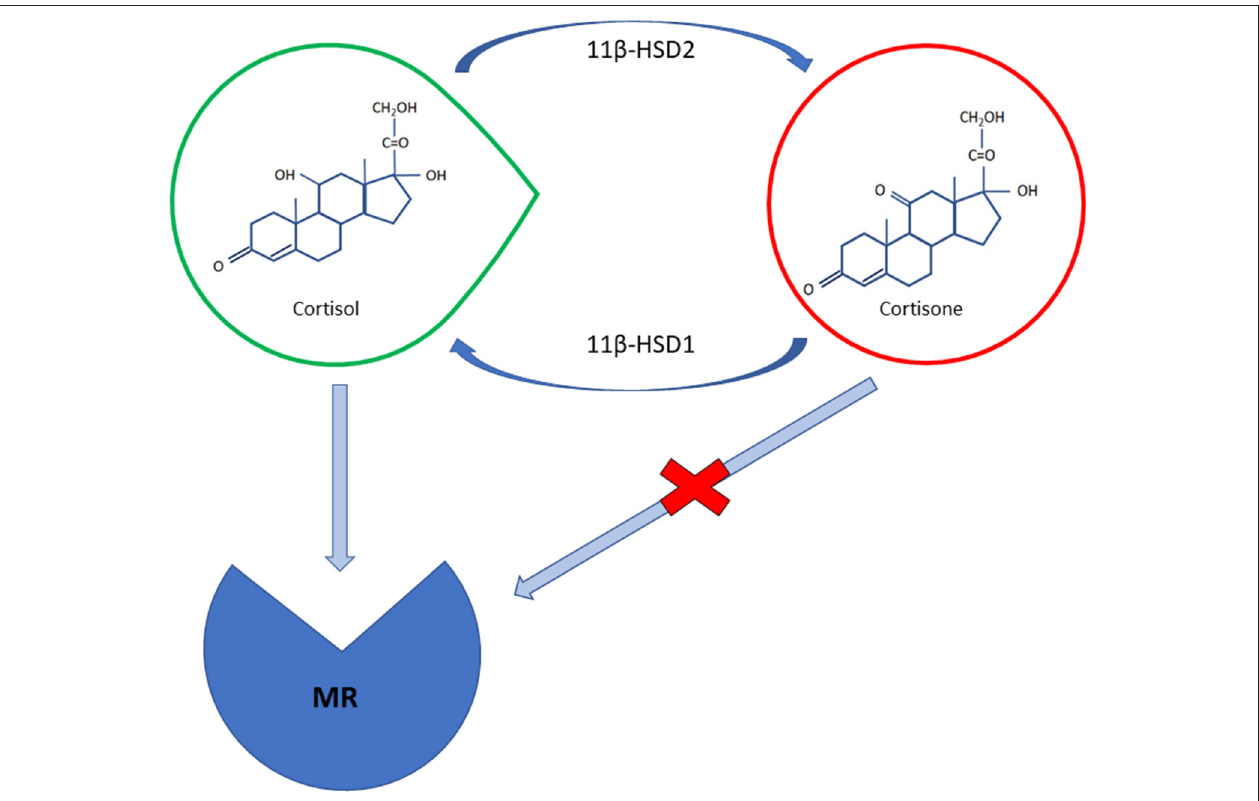
FIGURE 1 | A schematic illustration of cortisol and cortisone molecular structures; cortisol can bind to mineralocorticoid receptor (MR) with the same affinity as aldosterone; the 11 β -HSD2 enzyme converts cortisol in mineralocorticoid target tissues intos inactive cortisone preventing it from binding to MR. The intrinsic activity of 11 β -HSD1 in peripheral tissues, especially in the liver and in adipose cells, may constitute the main determinant as far as the control of BP and the metabolic manifestations of cortisol excess are